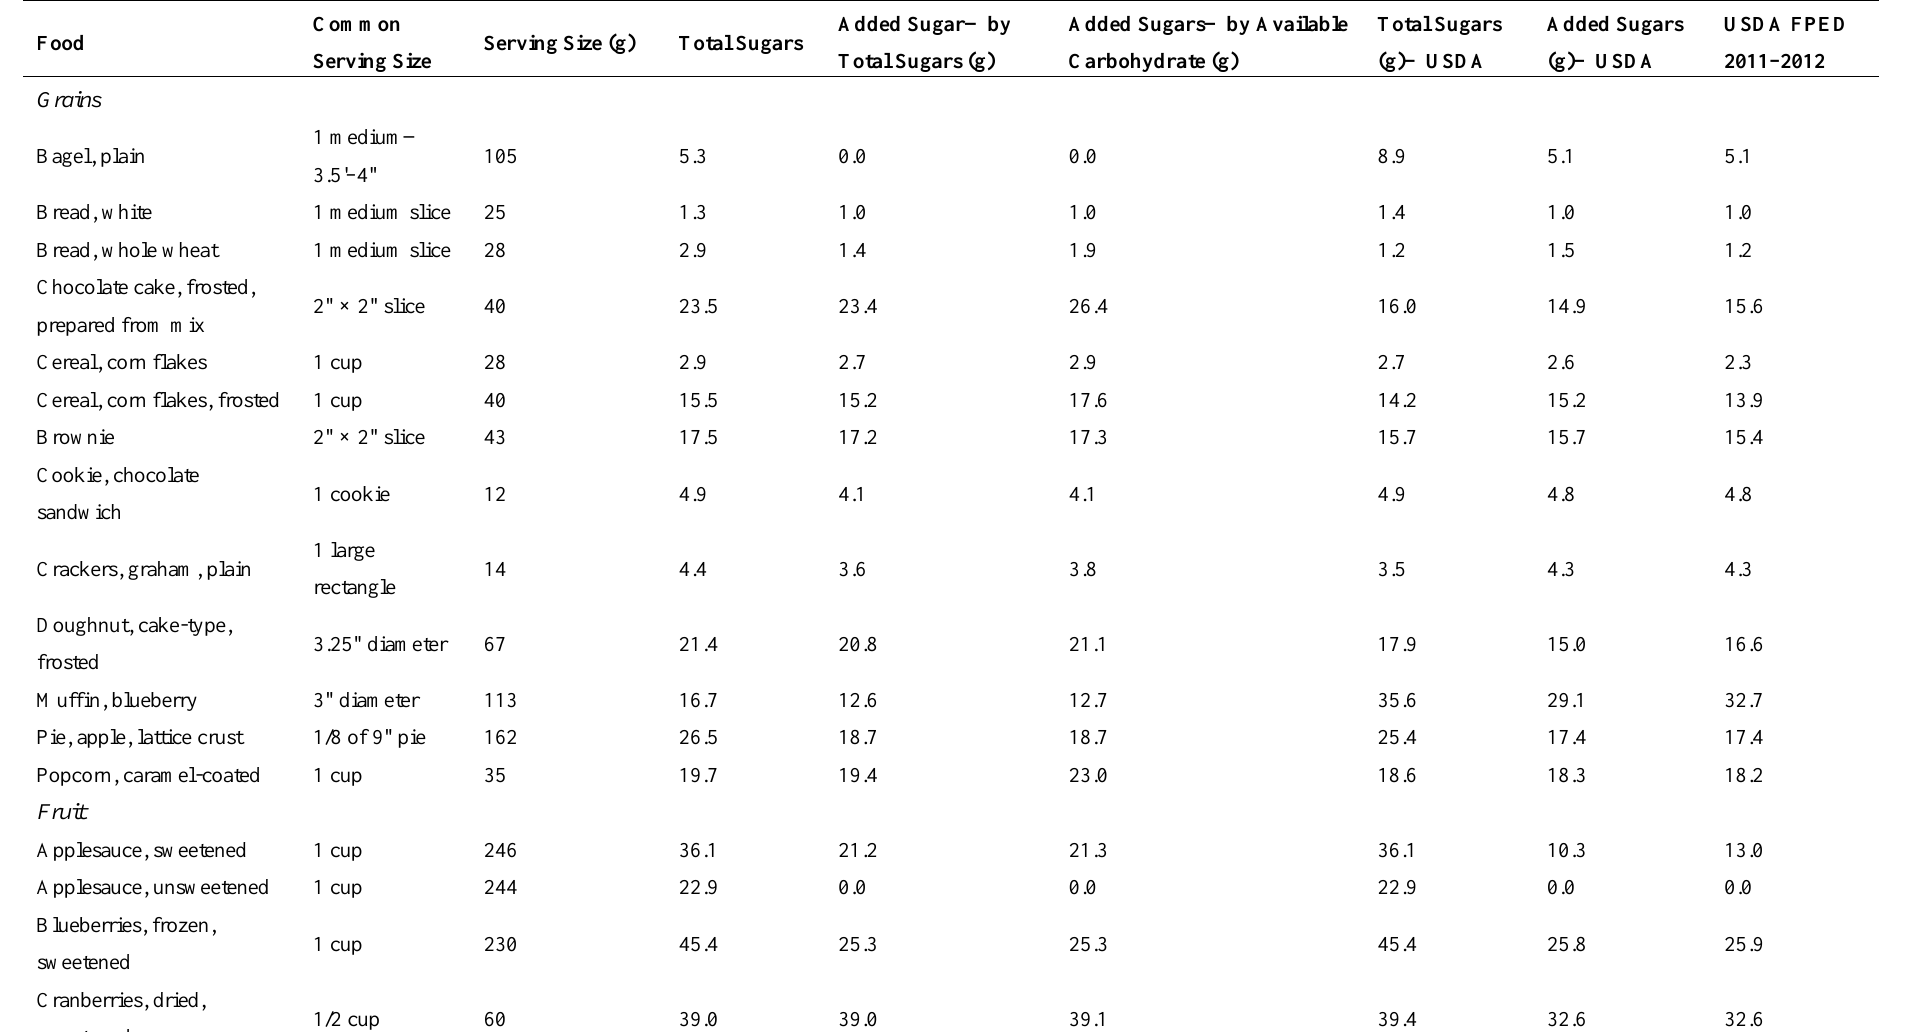
Table 2. Approximate total and added sugar content of selected